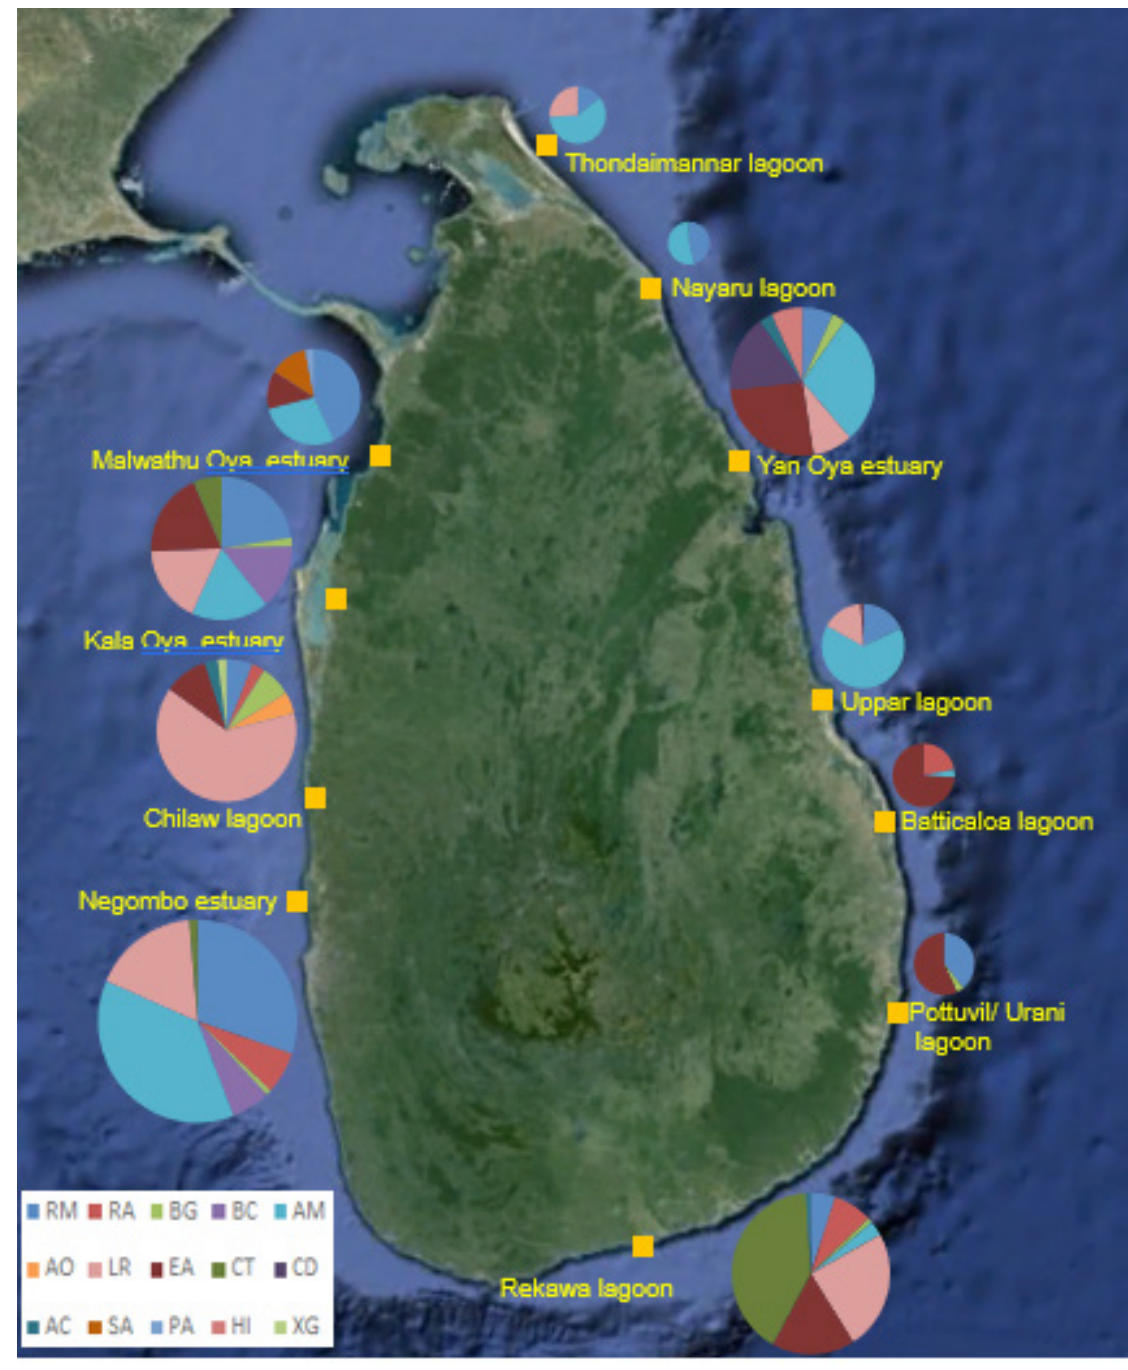
Figure 1: Study areas located eleven (11) estuaries/lagoons around Sri Lanka. supports the highest number of true mangrove